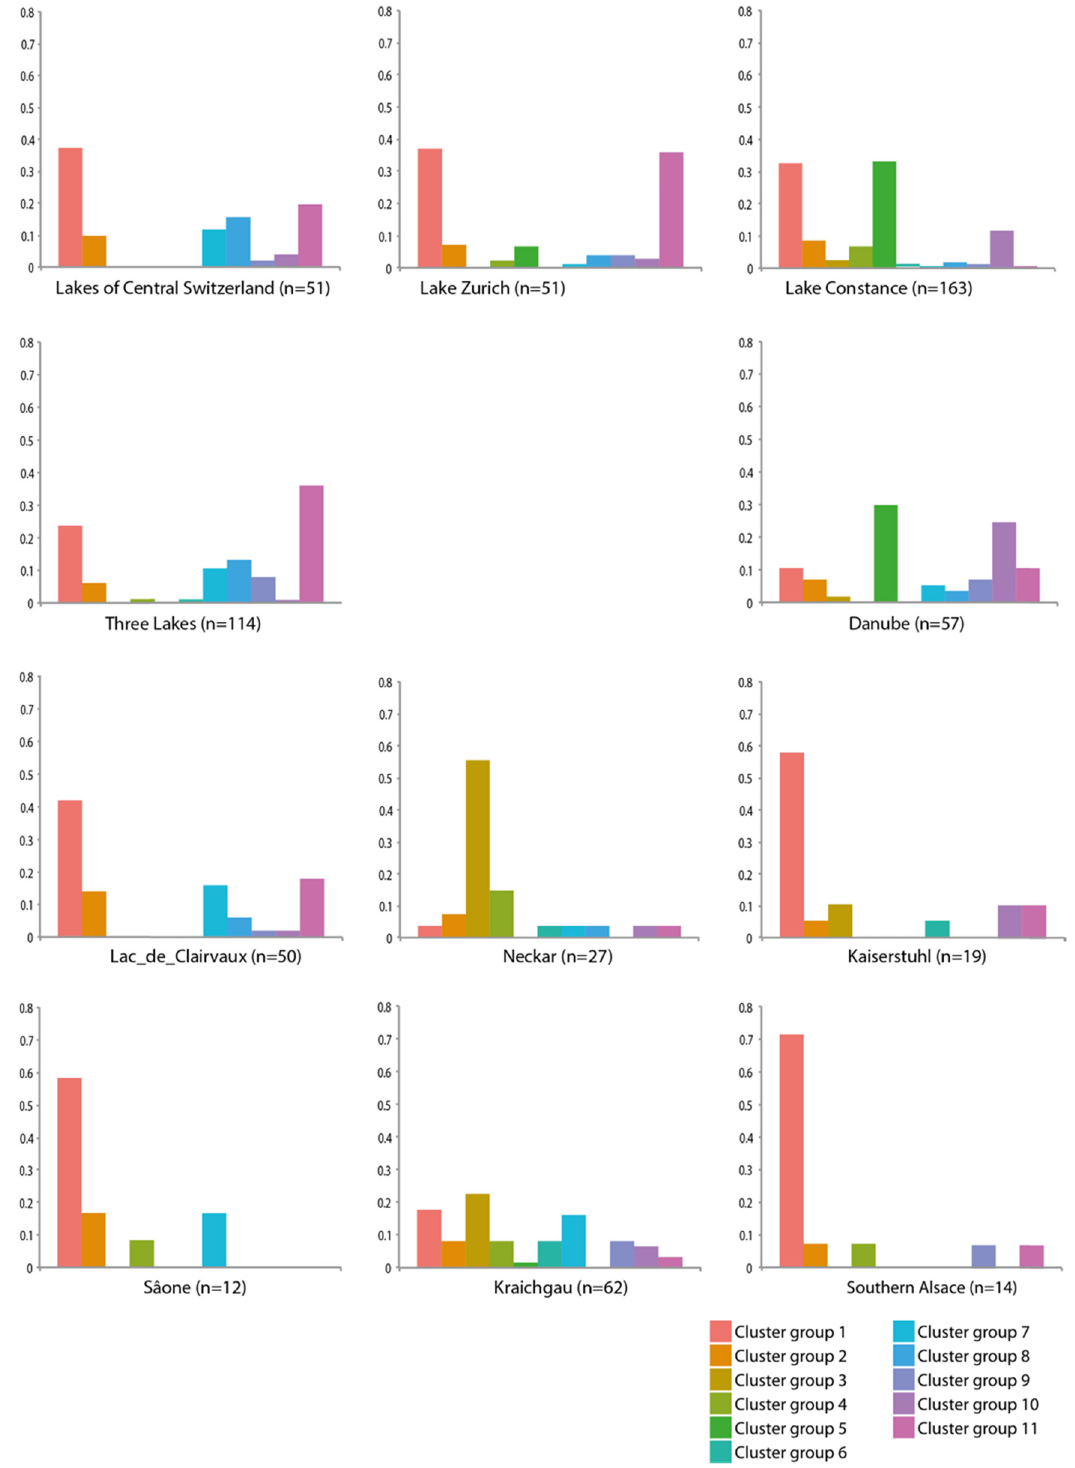
Figure 15: Relative frequencies of represented cluster groups per region ( fi gure: C. Heitz )